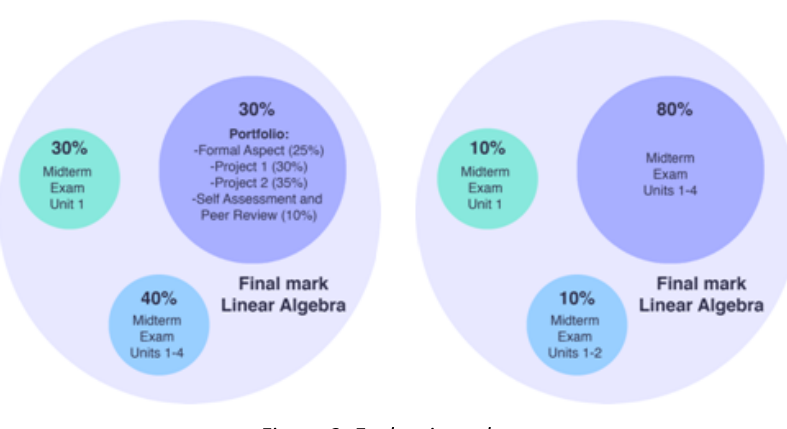
Figure 3. Evaluation scheme